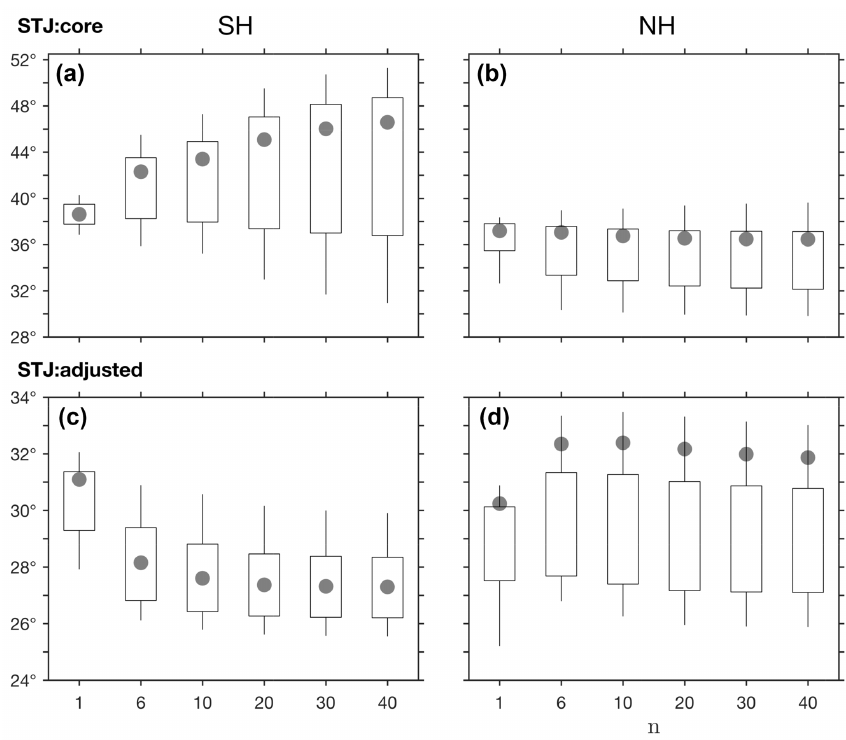
Figure 9. The dependence of the mean metric latitude on the smoothing parameter n for the STJ:core and STJ:adjusted methods, derived from annual means of the zonal-mean zonal wind in the SH (a, c) and NH (b, d) , for the period 1979–2004. For simplicity, positive values are used for both the NH and SH. Candle boxes show mean ± 1 standard deviation of CMIP5 inter-model spread (note, however, that different vertical scales are used for STJ:core and STJ:adjusted ). Candle wicks show maximal and minimal CMIP5 model values. ERAI values are shown in gray